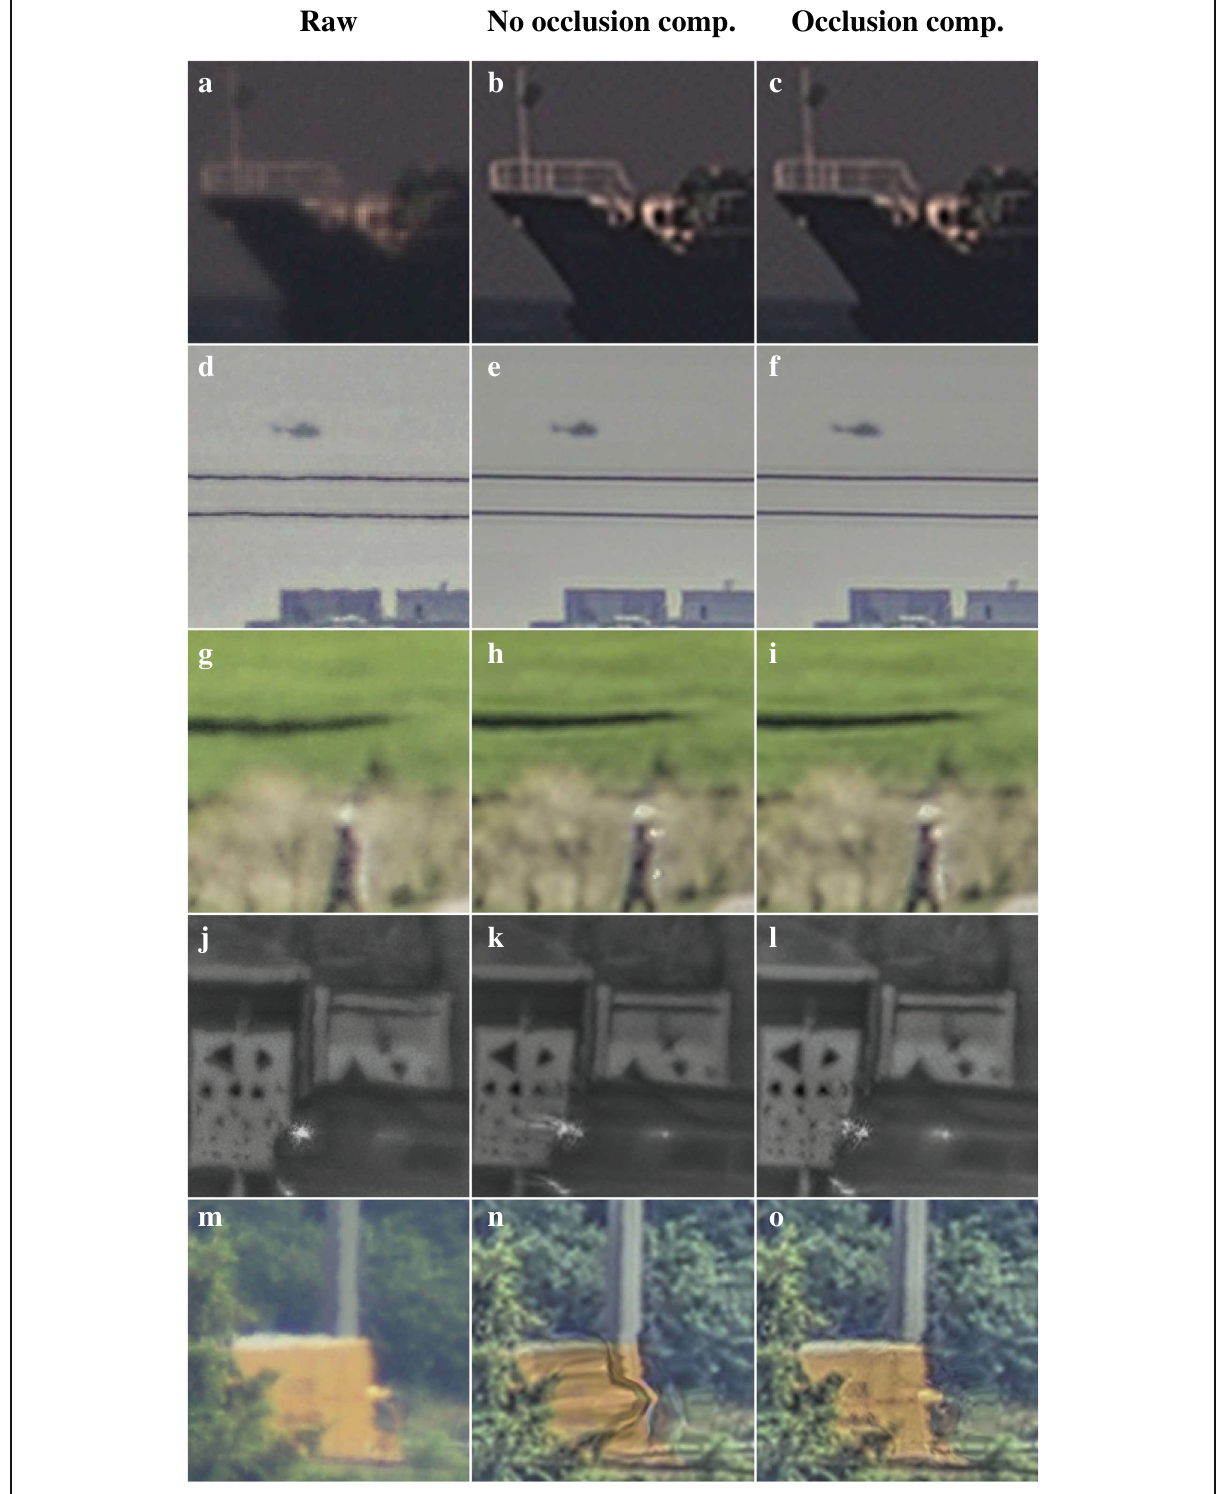
Fig. 13 Comparison of turbulence mitigation results with occlusion compensation (right column) and without (middle column). Lucas-Kanade optical flow estimation was used for the datasets shown in subfigures ( a – f ) and TV-L1 optical flow estimation for subfigures ( g – o